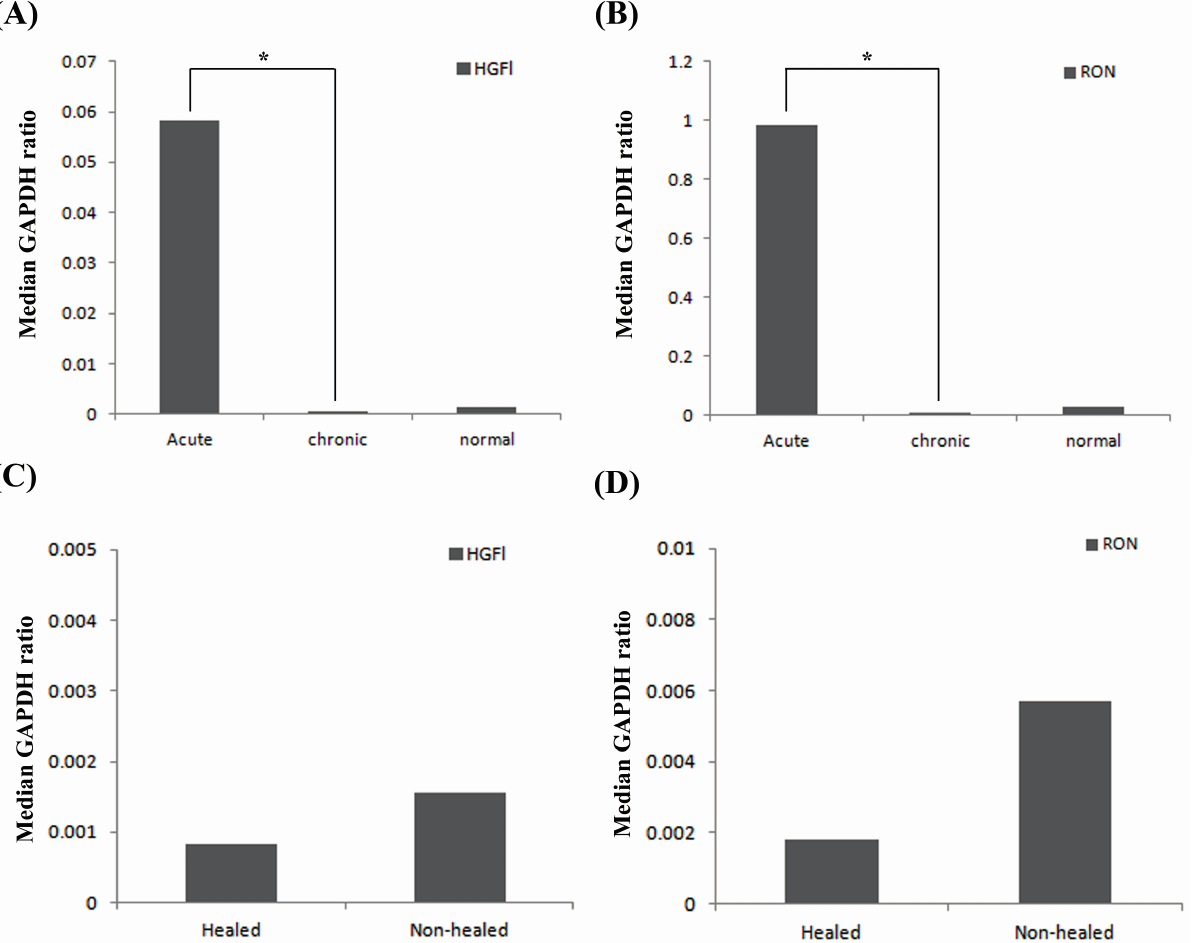
Figure 1. Q-PCR analysis of HGFl and RON transcript expression in clinical wound samples. Expression levels of both HGFl ( A ) and RON ( B ) were significantly elevated in acute wound tissues compared to chronic wound tissues; whereas, similar levels were detected between chronic wound tissues and normal skin. Minimal expression of HGFl ( C ) and RON ( D ) were detected in chronic, healing/non-healing wound tissue, and whilst slightly elevated in non-healing chronic wounds, no significant differences were discovered between the two types of chronic wound tissue for either HGFl or RON. Median GAPDH ratio shown. * represents p <